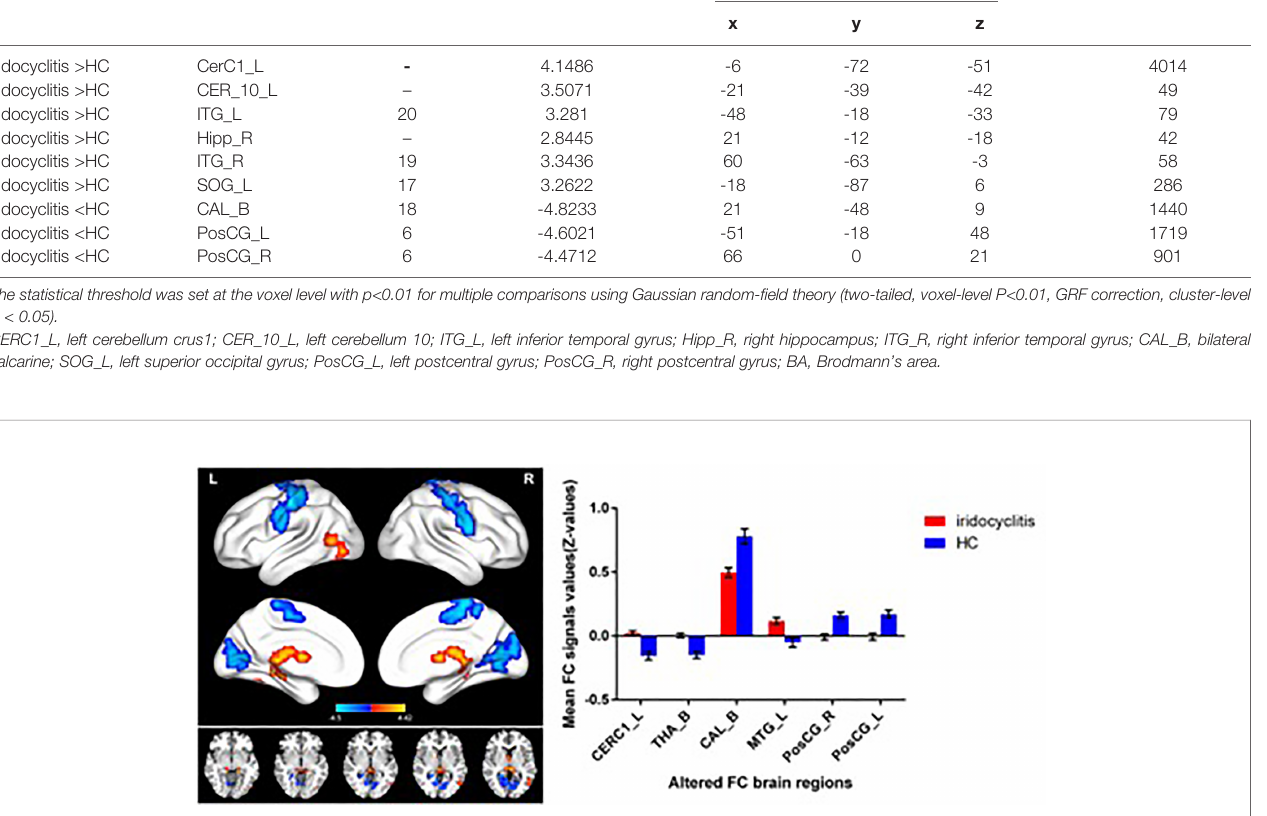
TABLE 3 | Signi fi cant differences in the left V1 between two groups. Condition